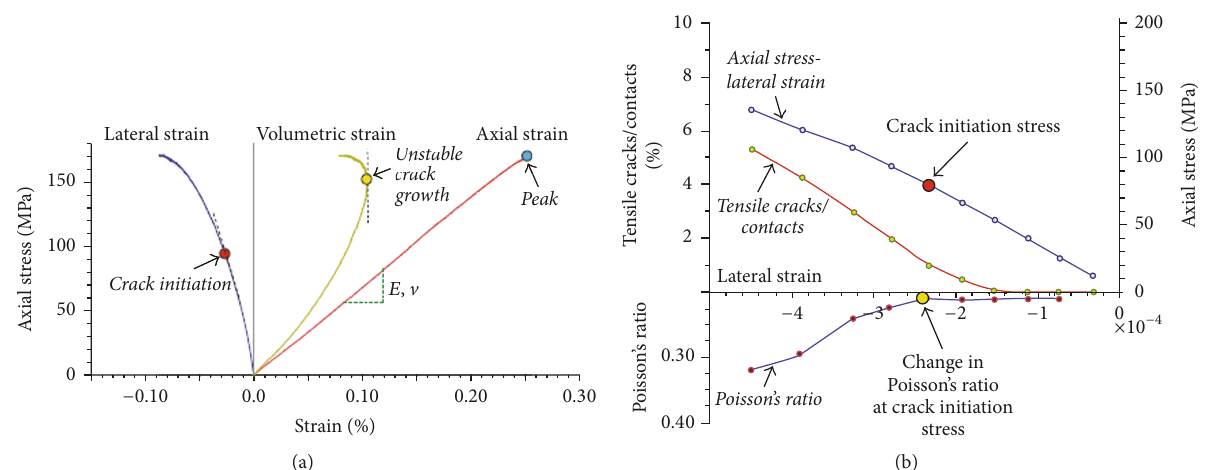
Figure 9: The methods used to establish crack initial stress and crack damage stress [19].